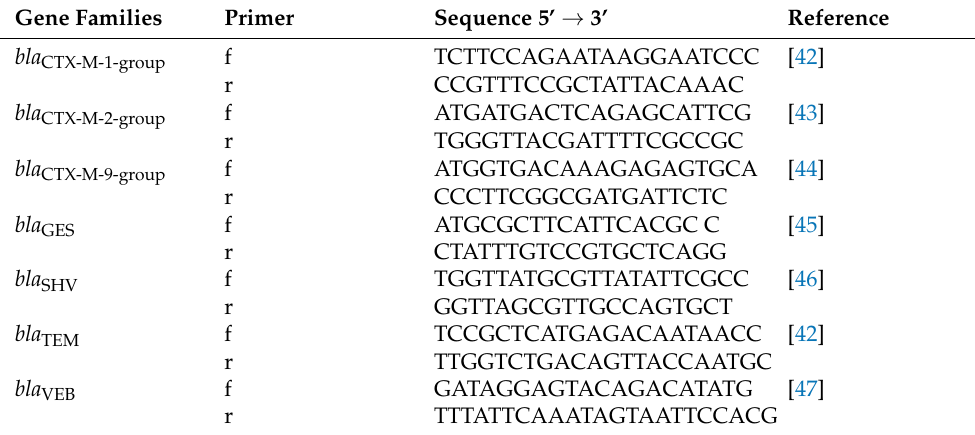
Table 4. Primers used for